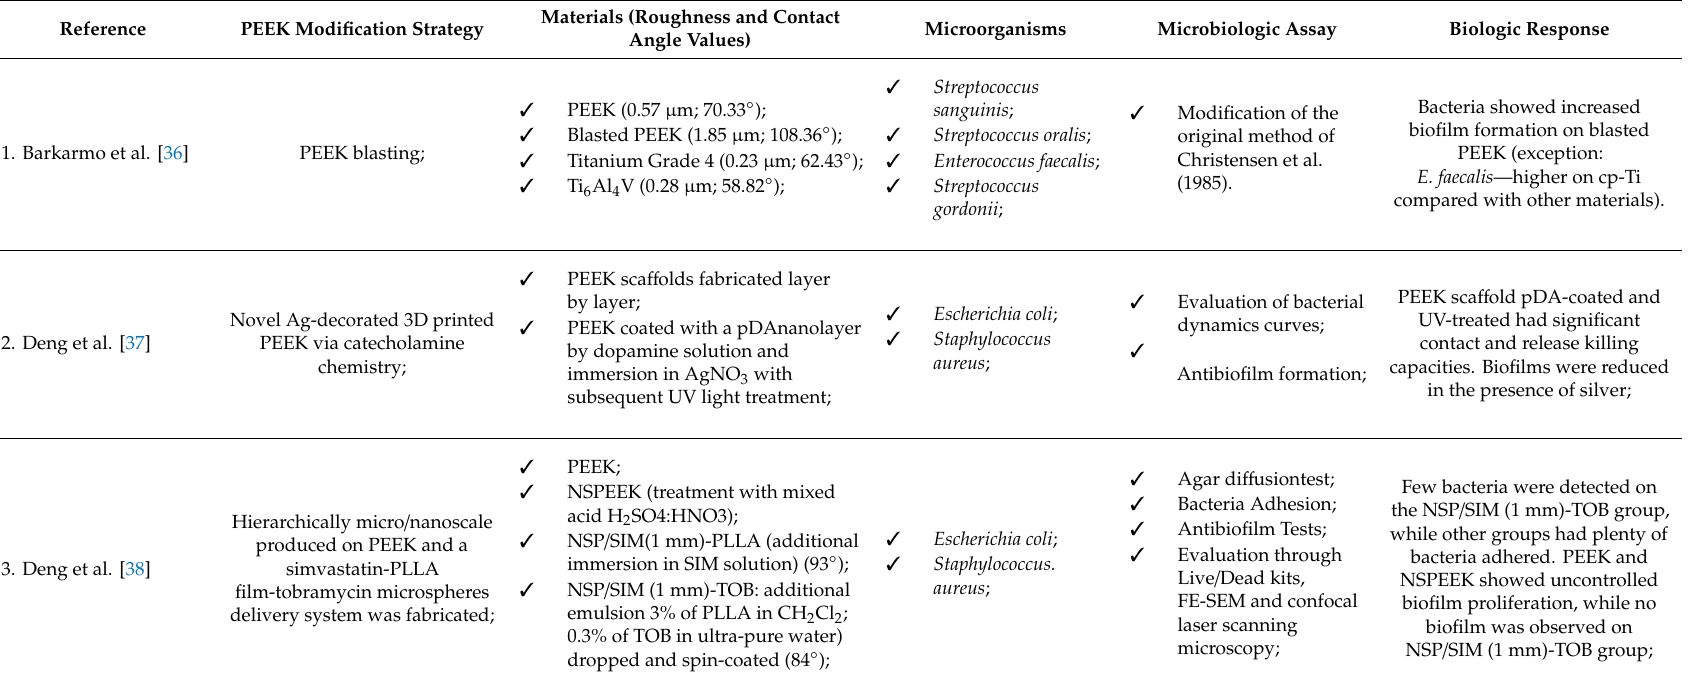
Table 2. Descriptive analysis of modified PEEK